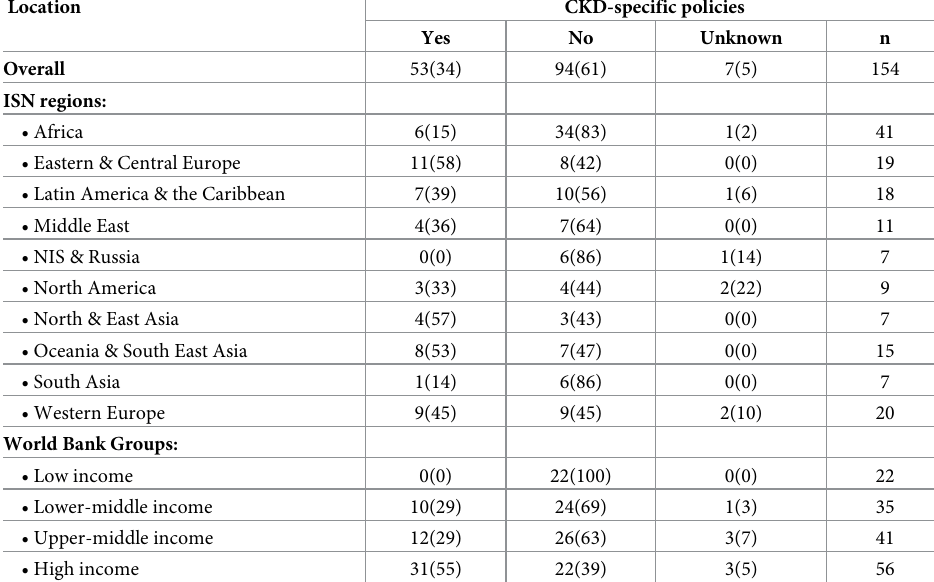
Table 2. Existence of CKD-specific policies around the world. Numbers represent countries (%). Location